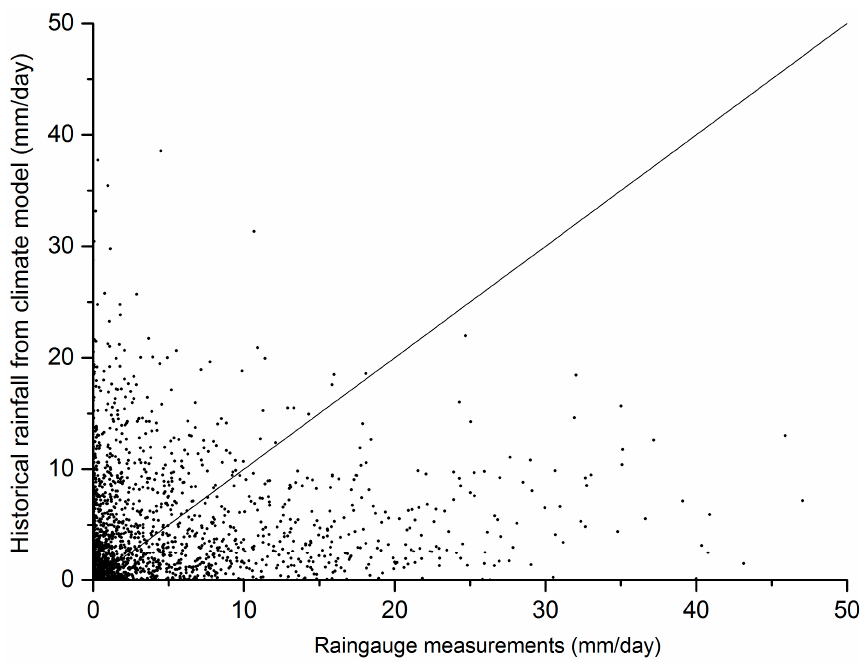
Figure 6. RF and rain gauge measurements in scatter map.